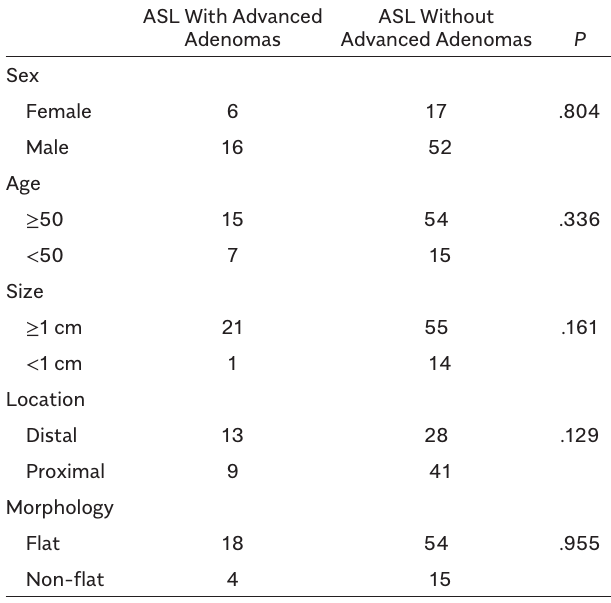
Table 4. The Relationship Between Advanced Serrated Lesions and Synchronous Advanced Adenomas ASL With Advanced